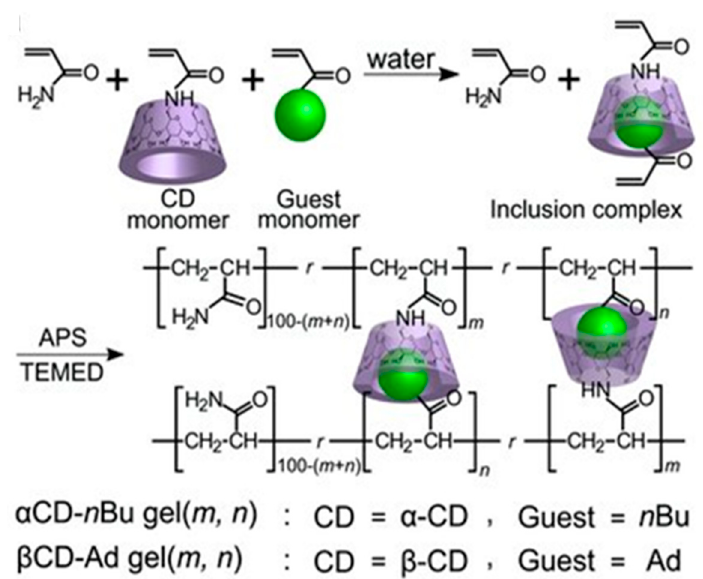
Figure 8. Preparation of host-guest supramolecular α CD-nBu gels ( m , n ) and β CD-Ad gels ( m , n ); m and n denote the mol% of the host unit and guest unit, respectively. Reprinted with permission from [114]. Copyright 2016 John Wiley and Sons.